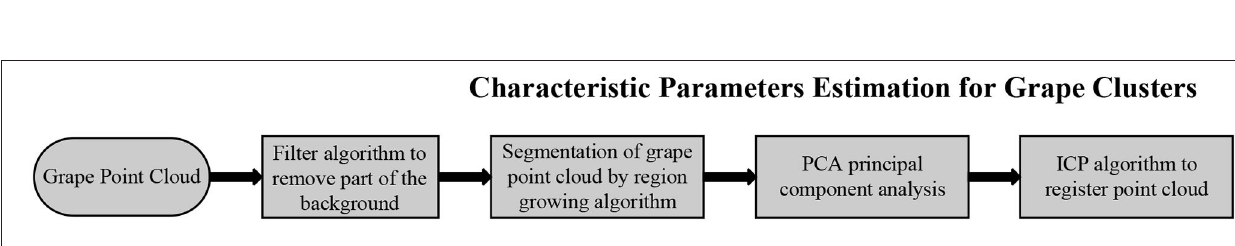
FIGURE 2 | Diagram of the location of the experimental equipment in the grape characteristic parameter measurement system.